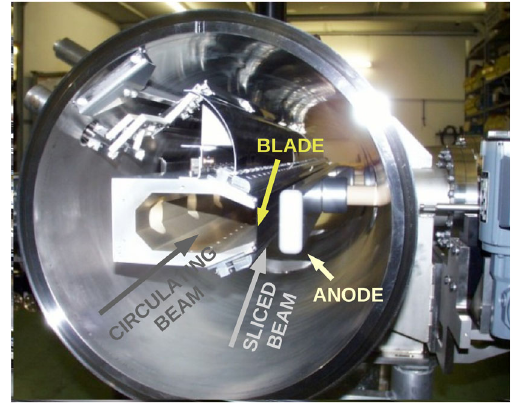
FIG. 11. Electrostatic septum 31. The circulating beam passes in the left vacuum pipe, whereas the electrical field is present at the right of the septum blade.